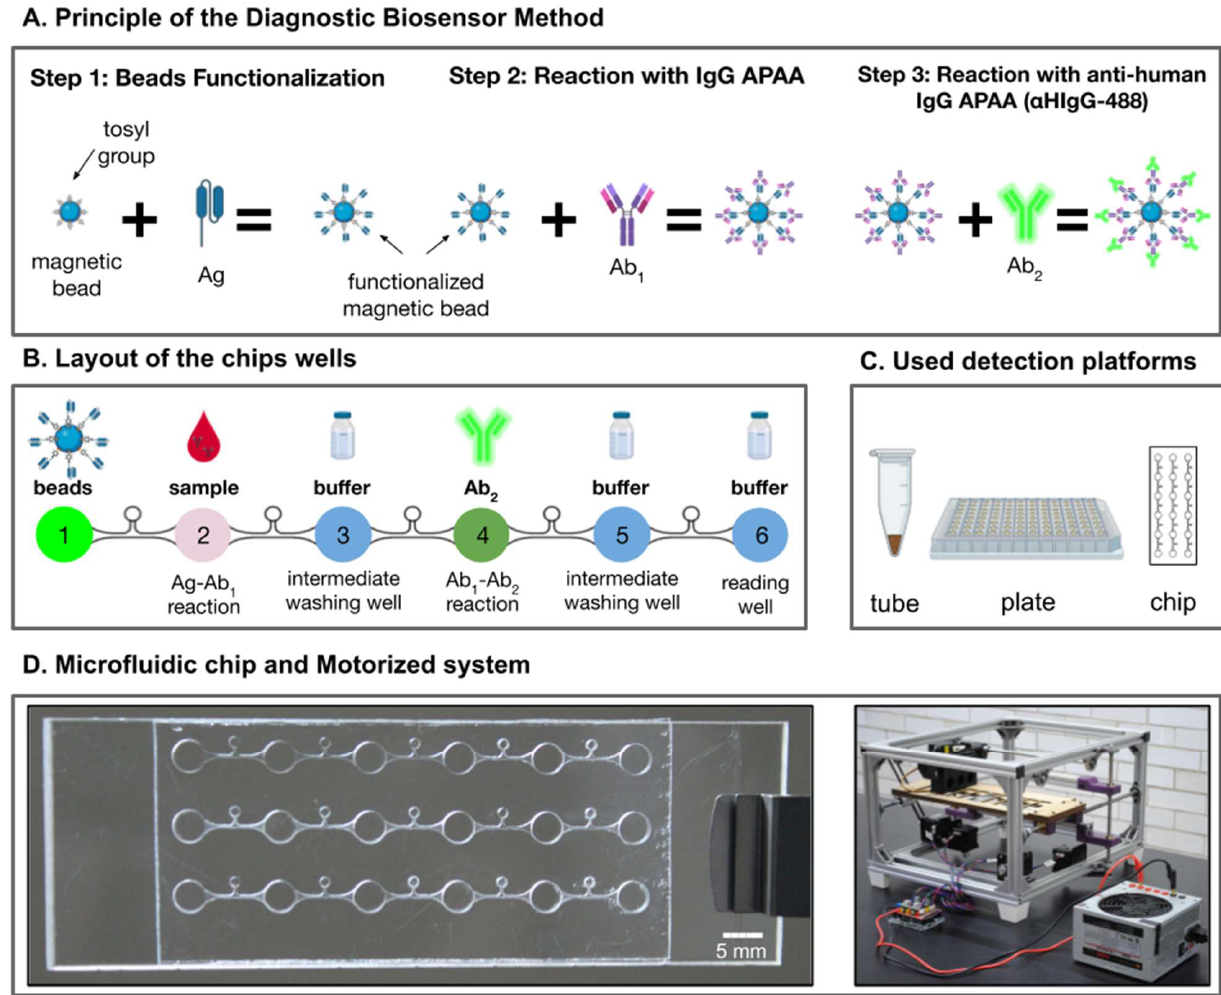
Figure 1. The schematization of the steps of the Diagnostic Biosensor Method. ( A ) Preparation and reactions used in the method; ( B ) details of the detection sequence followed inside the microfluidic chip; ( C ) schemes of the detection platforms used in this project. Ag: antigen, Ab1: primary antibody, Ab2: secondary antibody; ( D ) photographs of the chip design and the motorized platform used to control beads movement.